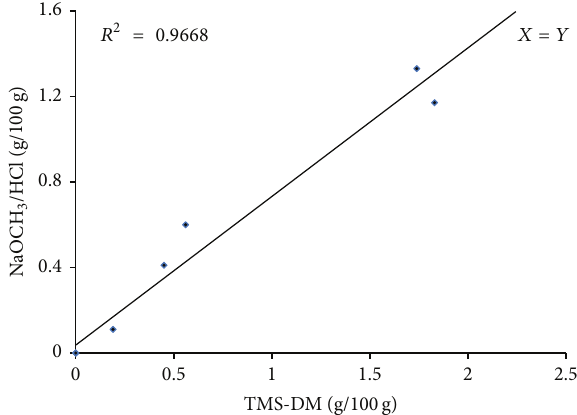
Figure 4: Comparison of C18:1 trans -9 measurements (g/100g) by GC-FID based on the KOCH 3 /HCl and TMS-DM derivatization